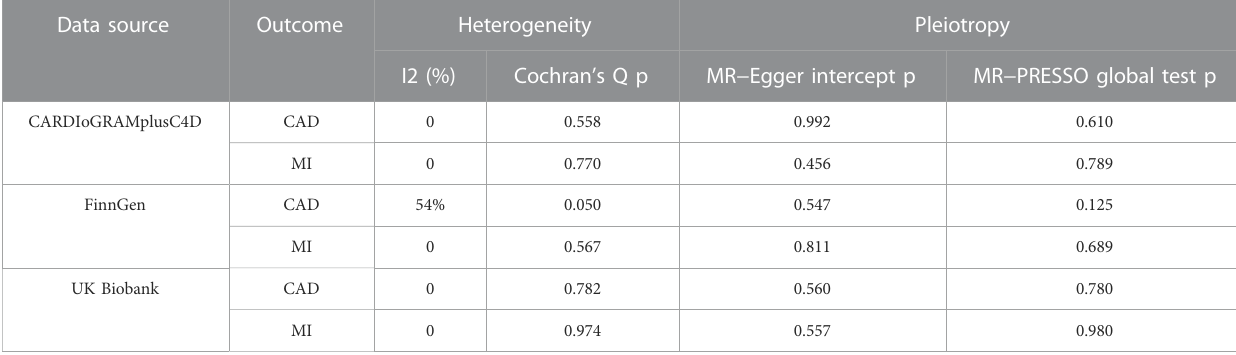
TABLE 3 Evaluation of heterogeneity and directional pleiotropy using different methods on RuminococcusUCG010 with CAD/MI. Data source